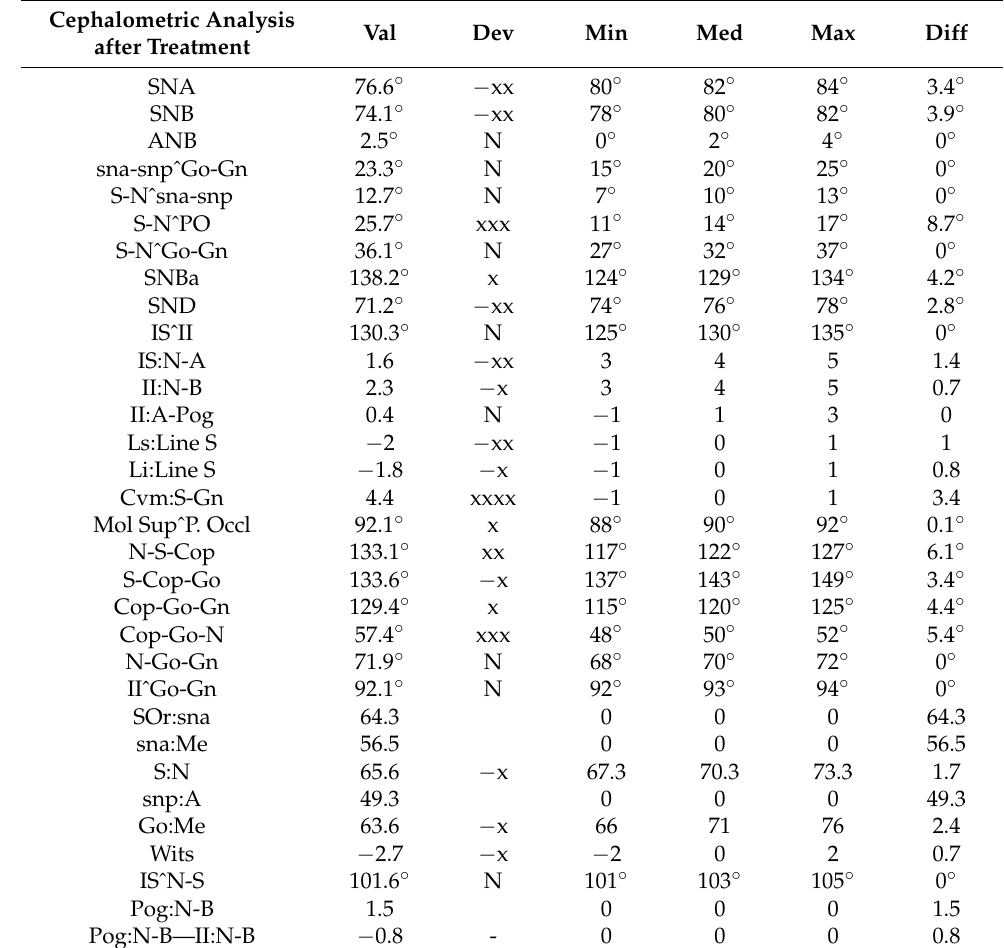
Table 8. Cephalometric analysis after treatment and a 3-year follow-up period. Cephalometric